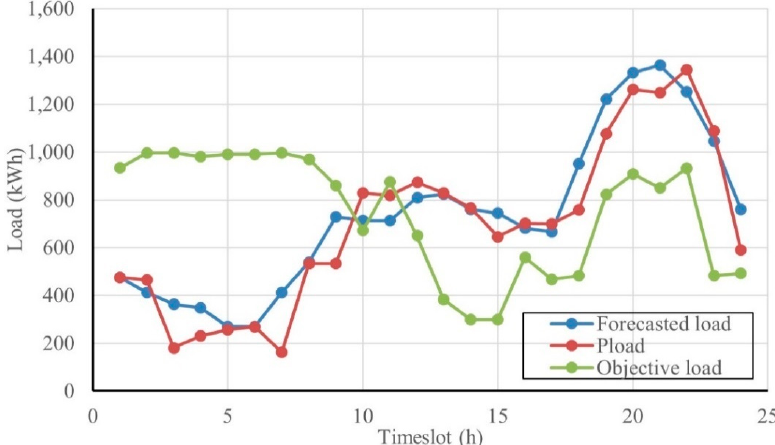
Figure 8. Hourly residential load before and after shifting using TOU-SBY.